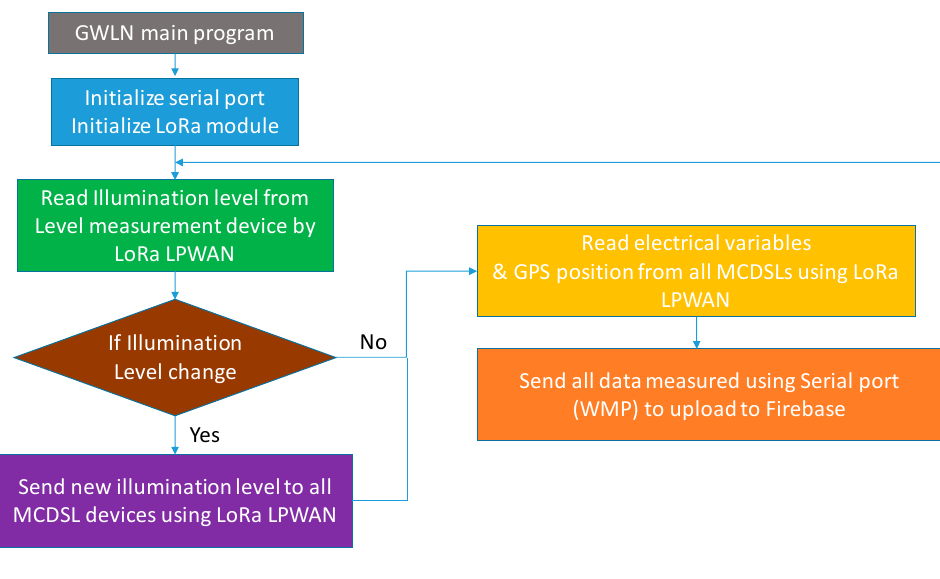
Figure 8. GWLN main program.